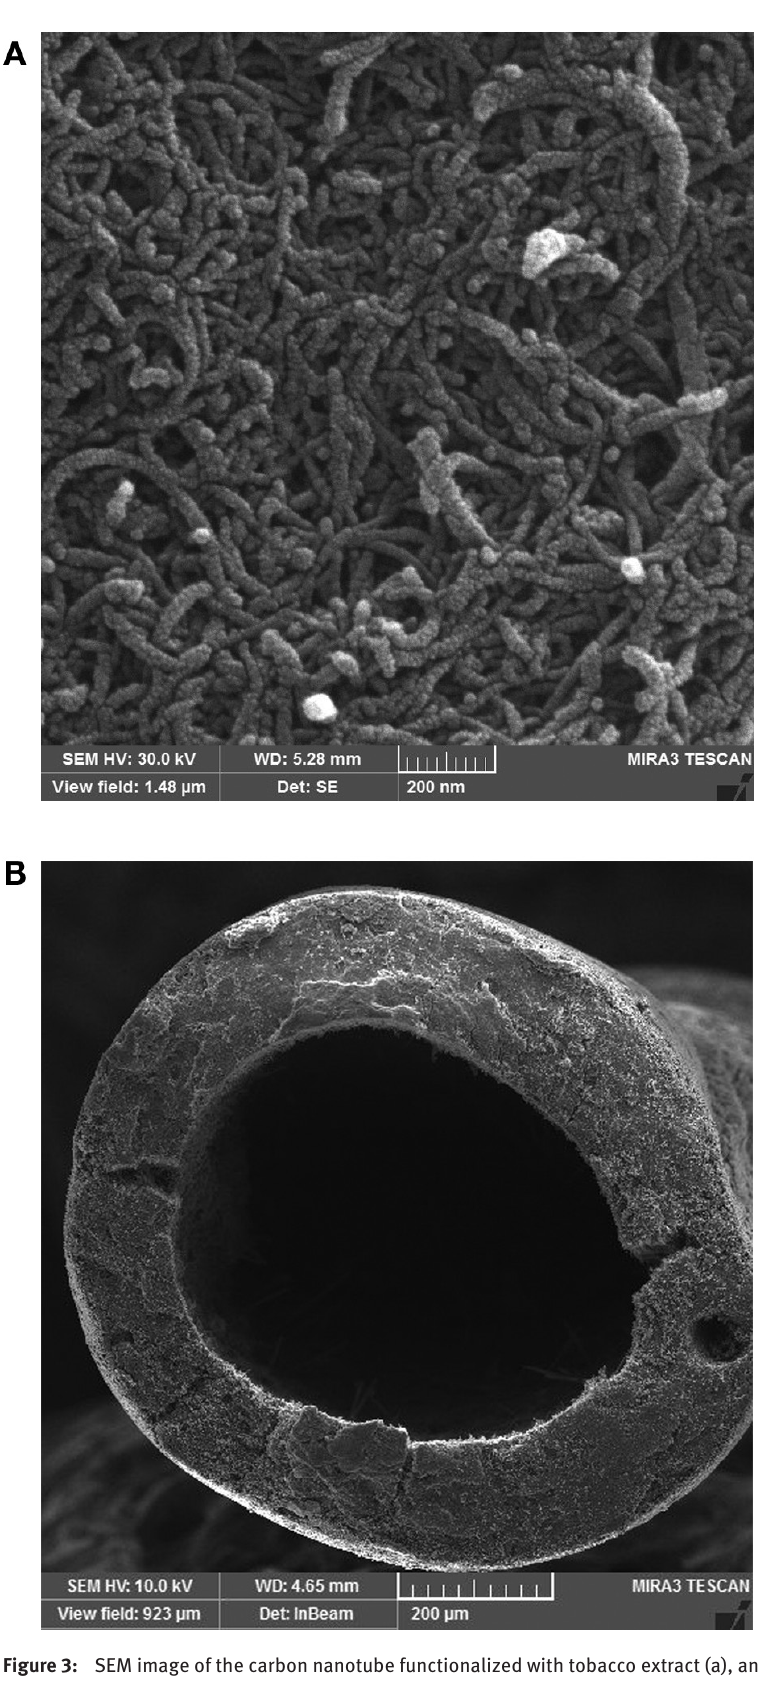
Figure 3: SEM image of the carbon nanotube functionalized with tobacco extract (a), and microstructure of the hallow fiber